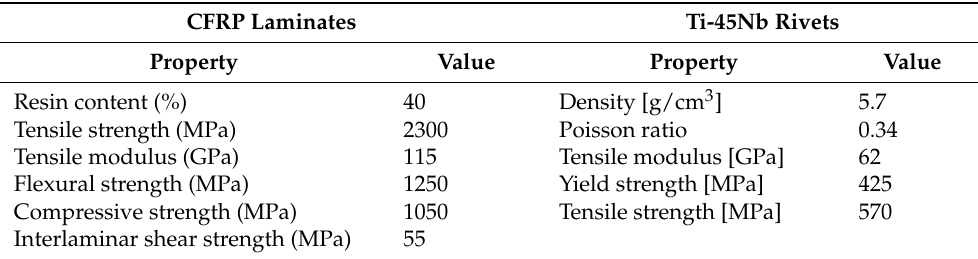
Table 1. Mechanical properties of the